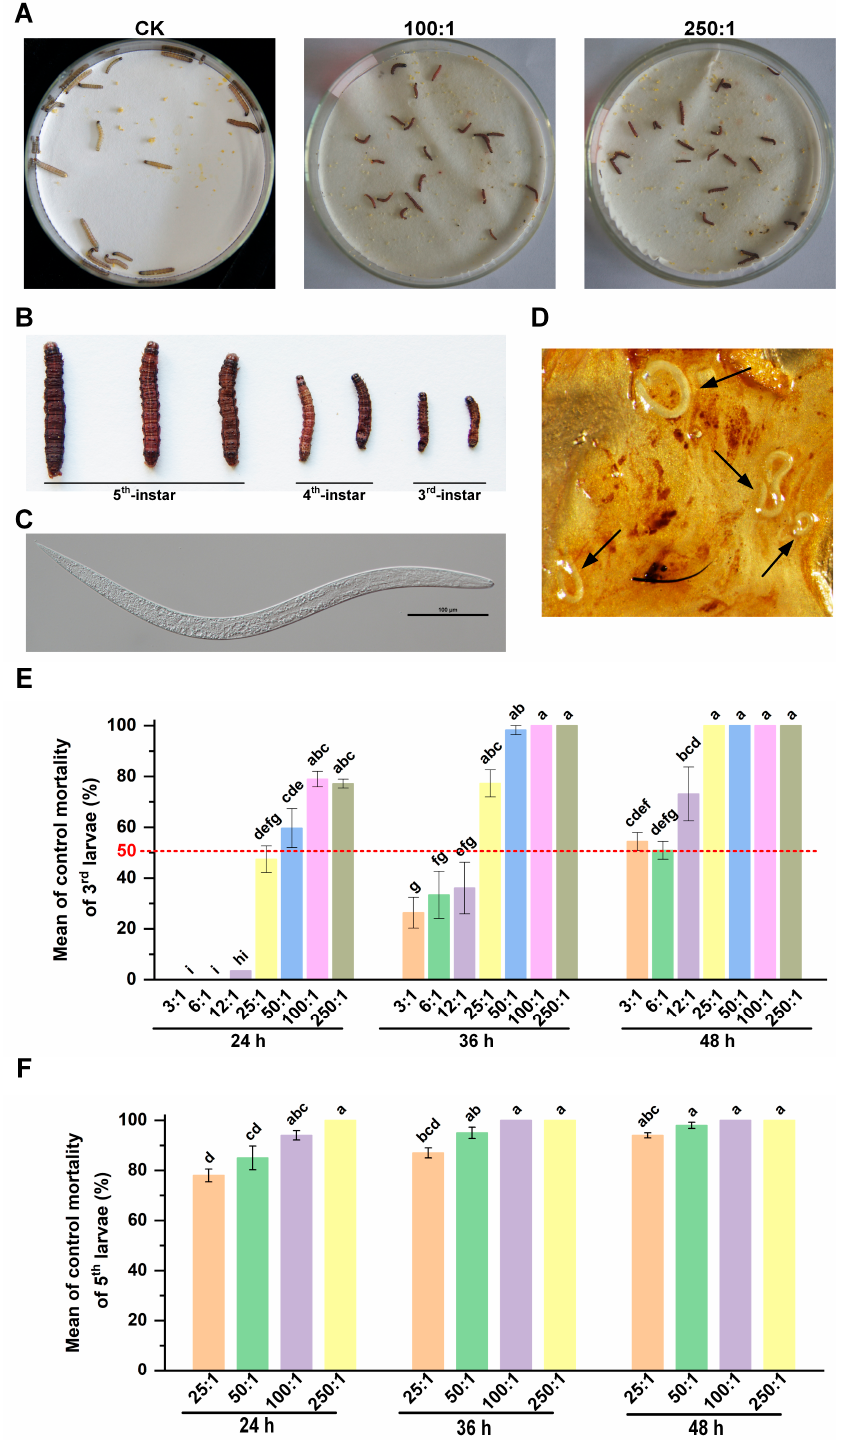
Figure 1. HbSD efficacy against S. frugiperda in Petri plate bioassays. ( A ) Representative plates containing 3rd instar larvae of S. frugiperda treated with water and HbSD suspensions at 48 h post-treatment. ( B ) The cadavers of S. frugiperda caused by HbSD infection for 48 h. ( C ) Observation of infective juvenile of HbSD under microscope. ( D ) The body contents inside the cadaver of S. frugiperda under stereomicroscope. The arrows indicate HbSD nematodes entered the insect body. ( E , F ) The mean control mortality (% ± SE) of 3rd ( E ) and 5th ( F ) larval stages of S. frugiperda treated with HbSD in Petri plates. The significant differences are exhibited by lowercase letters ( p < 0.05) according to Tukey’s HSD